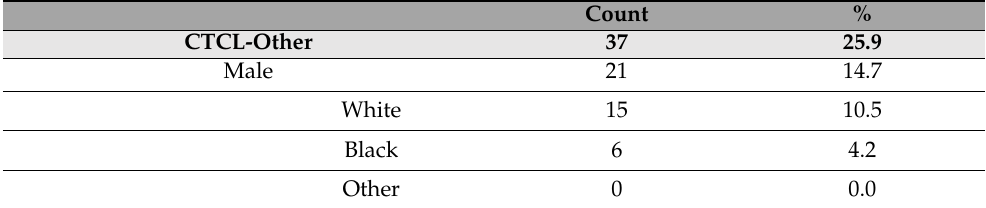
Table 1. Demographics of cutaneous T-cell lymphoma patients in